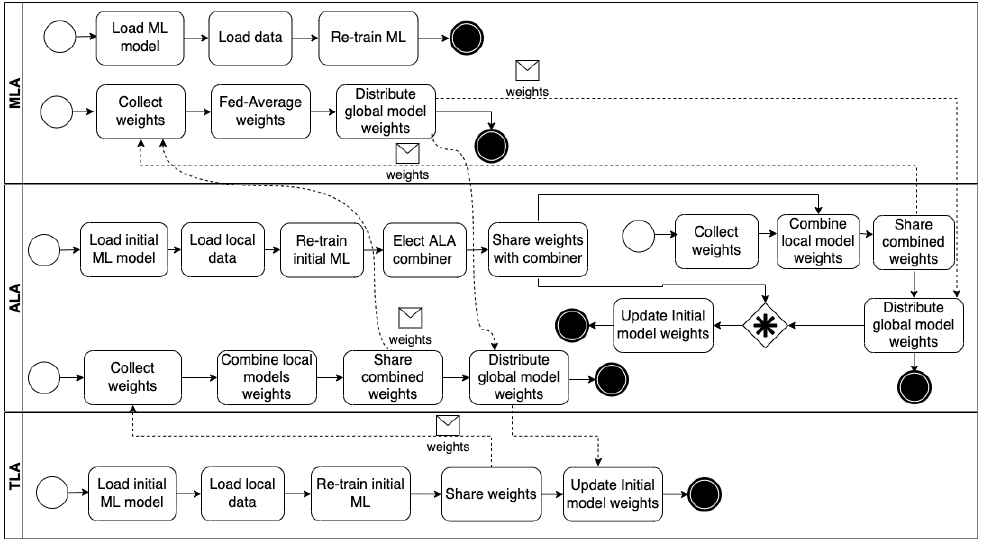
Figure 11. The federated learning